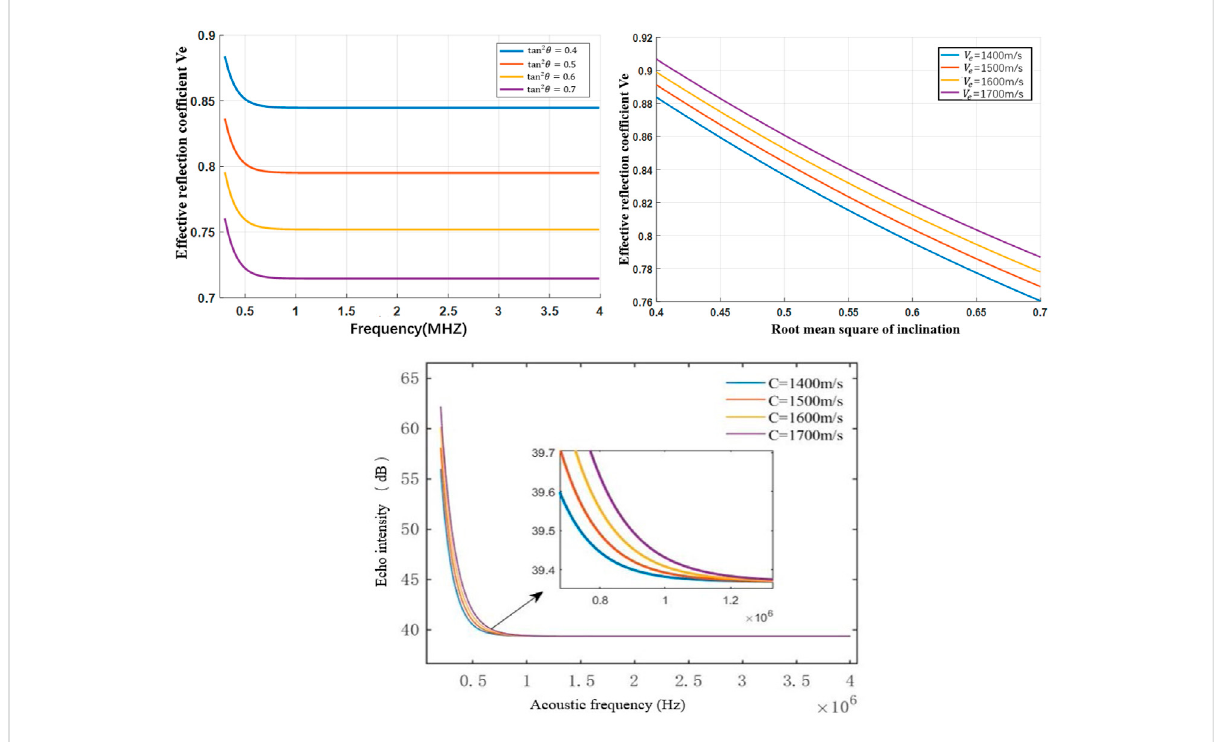
FIGURE 3 Relationship between sound frequency and echo intensity at different sound speeds.